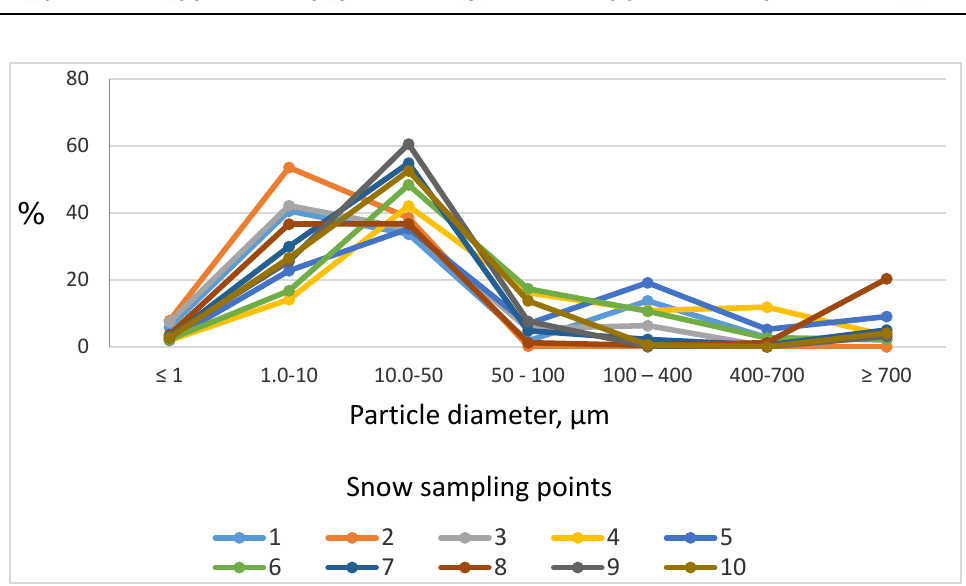
Figure 2. Particle size distribution of particulate matter measured in melted snow samples from Dalnegorsk town.